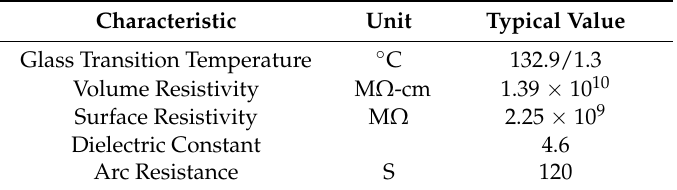
Table 1. Properties of the PCB designed in this study.